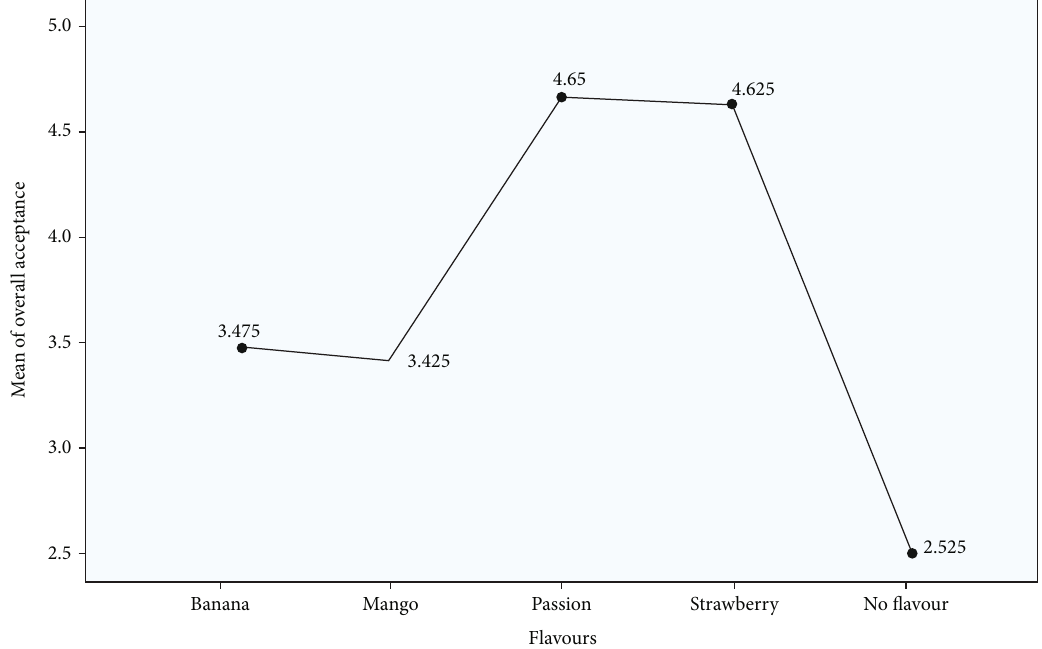
Figure 2: Means of overall acceptance of the four yoghurt fl avors. Strawberry- and passion- fl avored yoghurts were the most preferred. Table 4: Homogeneous subsets of the di ff erent yoghurt fl avors.